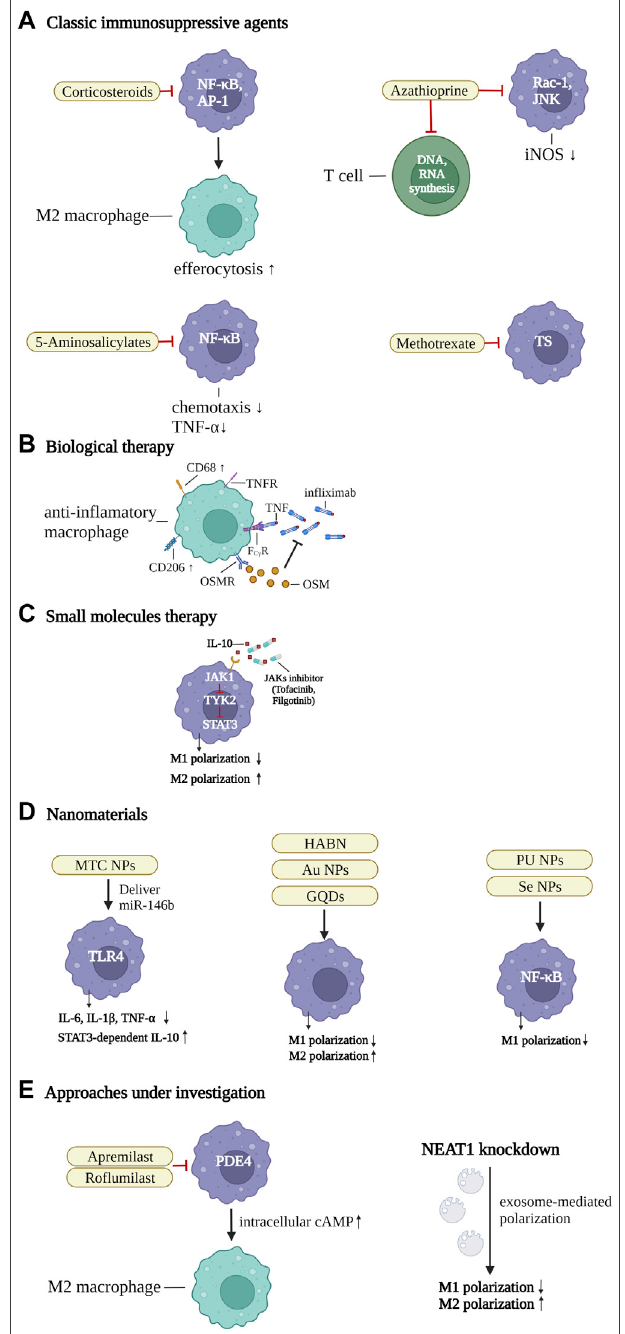
FIGURE3| TherapeuticstrategiesofIBDbytargetingthemacrophages. (A) classic immunosuppressive agents. Corticosteroids inhibit nuclear factor- κ B (NF- κ B) and activator protein 1 (AP-1), thereby enhancing efferocytosis and inducing the differentiation of M2 macrophages. 5-Aminosalicylate suppressesNF- κ BtodownregulateTNF- α effectsandcontrolthechemotaxis of macrophages. Azathioprine not only restricts T-cell activation by abolishing DNA or RNA synthesis, but also suppresses Ras-related C3 botulinum toxin substrate 1 (Rac1) activity and the phosphorylation of JUN N-terminal kinase, and the expression of iNOS. Methotrexate regulates pro-in fl ammatory gene expression of macrophages, by controlling thymidylate synthase (TS), (B) ( Continued )